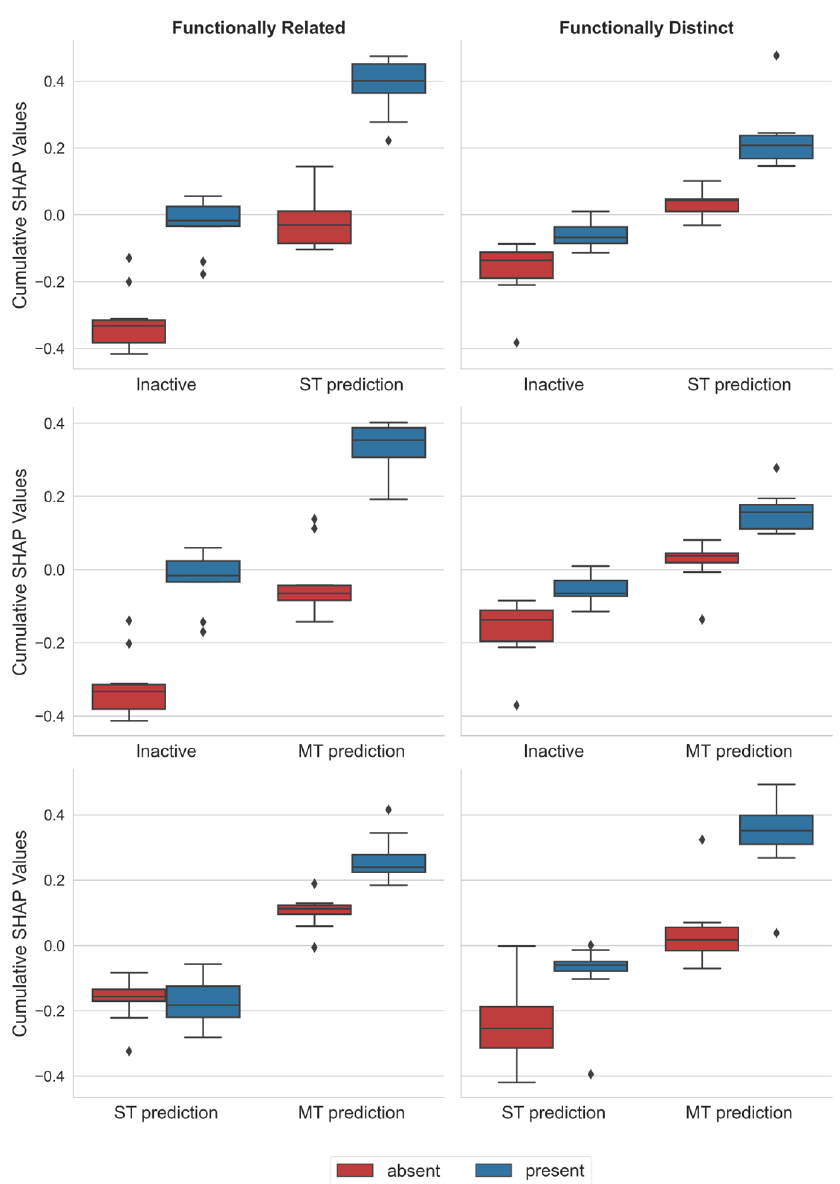
Figure 2. Cumulative SHAP analysis. Contributions of features absent (red) or present (blue) in test compounds were quantified using SHAP values across all correctly predicted randomly collected compounds (designated inactive), ST-, and MT-CPDs. Feature contributions are reported for three prediction tasks: ST model prediction of randomly selected vs. ST-CPDs (top), ST model prediction of random vs. MT-CPDs (middle), and MT model prediction of ST- vs. MT-CPDs (bottom).